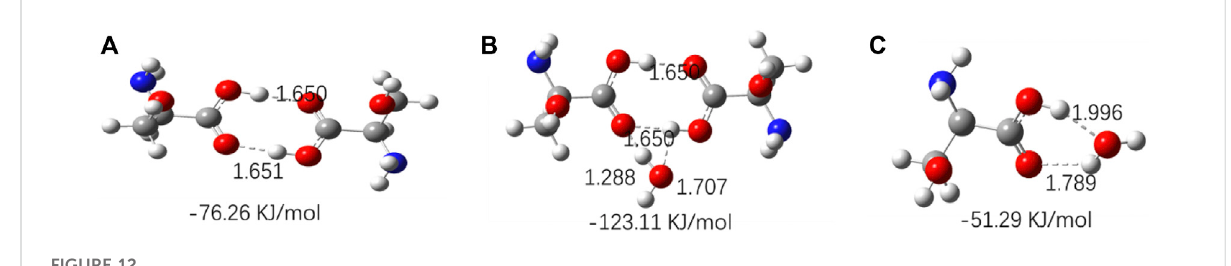
FIGURE 12 Optimized geometries for the amino acid complexes. (A) L -Serine (dimer); (B) L -serine – H 2 O complexes; (C) L -serine + H 2 O complexes; hydrogenbondsaredenotedbydashedlines,andthecorrespondingH ··· OandN ··· Hdistancesarelabeled.Theinteractionenergyofeachcomplexis noted below the structure.